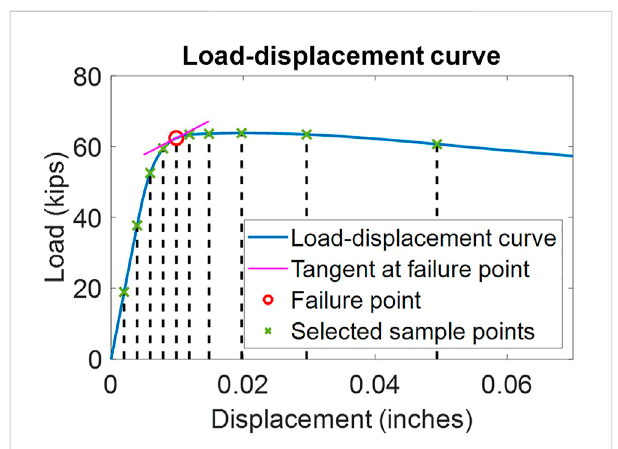
FIGURE 4 A sample load-displacement curve for a typical plate